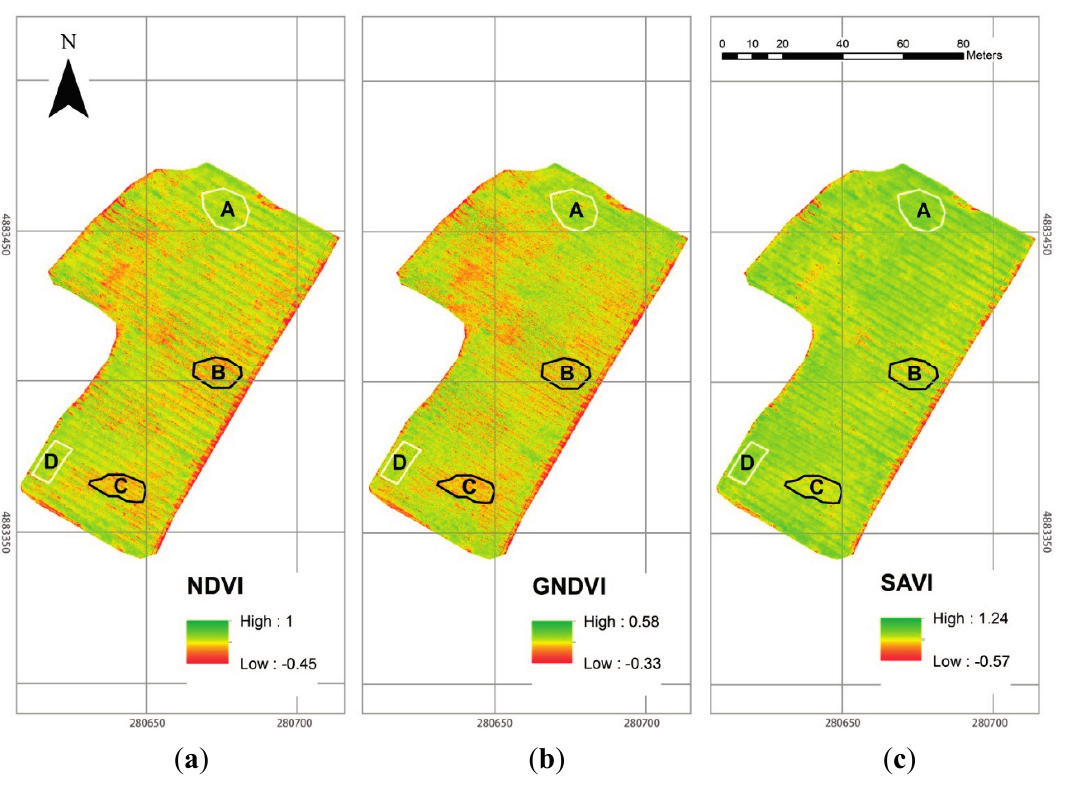
Figure 7. The NDVI ( a ), GNDVI ( b ), and SAVI ( c , with L = 0.25) maps for the vineyard area. Areas A–D and C–B show zones with high and low VI values,